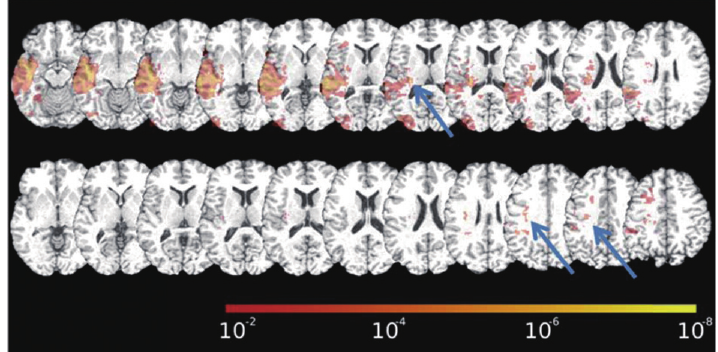
Fig. 1. Statistical map of associations between core infarct and each type of motor extinction using Fisher exact tests. Top panel: map of the association between infarct and presence of left canonical body motor extinction. Bottom panel: map of the association between infarct and presence of left space motor extinction. The color bar shows the corresponding p-values for the association in each voxel. Blue arrows point to the voxel clusters with the highest associations by Fisher exact